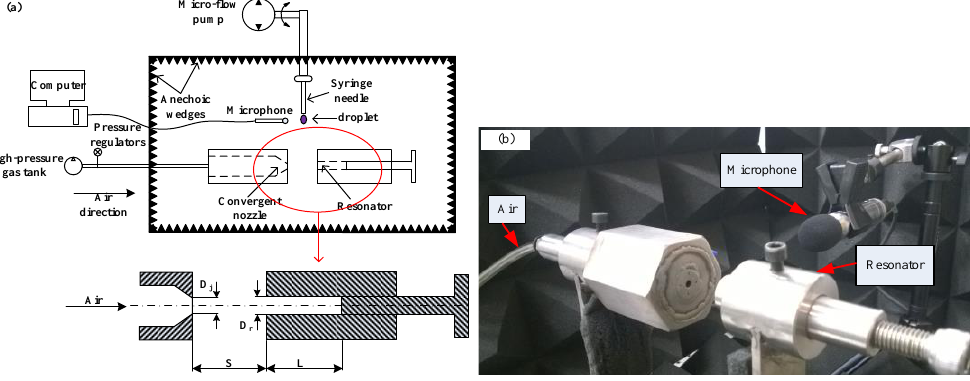
Figure 1. Schematic of the experimental setup: ( a ) overall experimental system; ( b ) acoustic detection section.